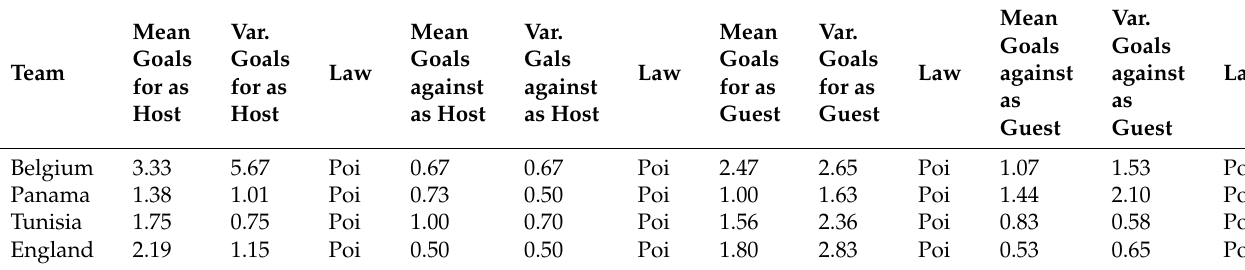
Table 12. Group G in Russia 2018.